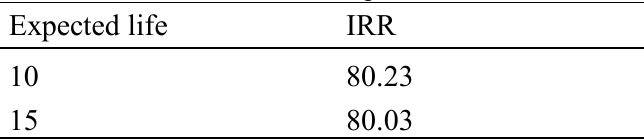
Table 16. Results for different expected lifetimes